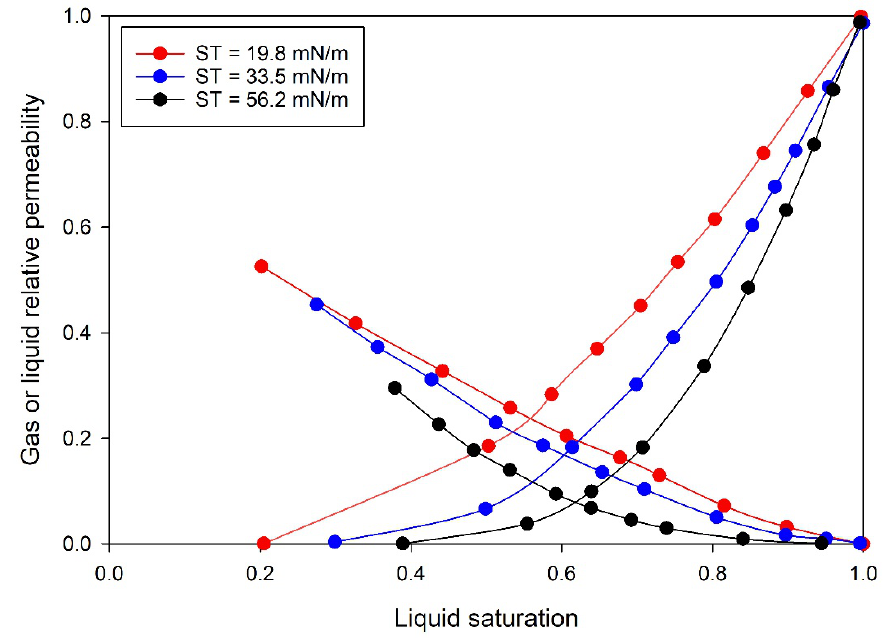
ff ect of surface tension on gas / liquid-relative permeability Figure 3. Effect of surface tension on gas/liquid-relative permeability [37]. Figure 3. E